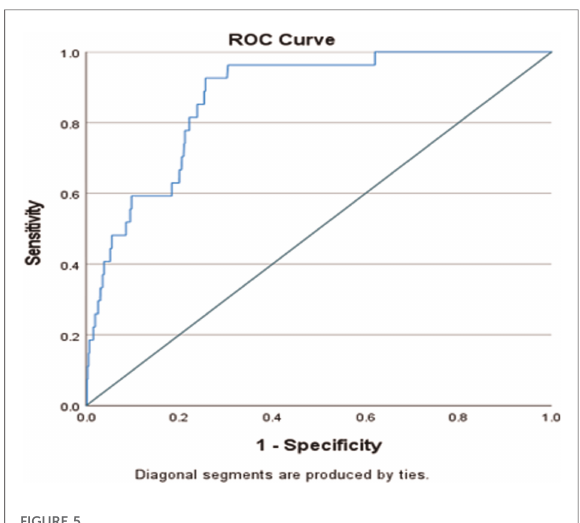
FIGURE 5 Area under the curve (AUC) value: 0.871 (95% CI, 0.82,